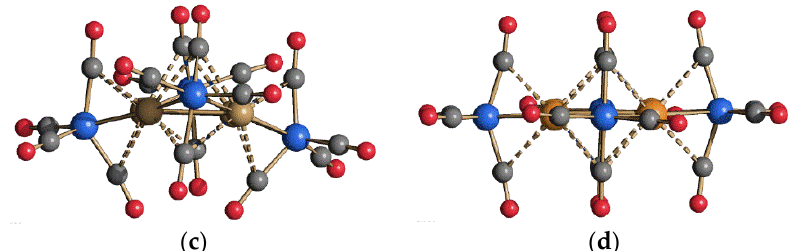
Figure 1. Two views of the molecular structures of ( a , c ) {CuCo(CO) 4 } 4 [36] and ( b , d ) {AgCo(CO) 4 } 4 (brown, Cu; orange, Ag; blue, Co; red, O; grey, C) [38].